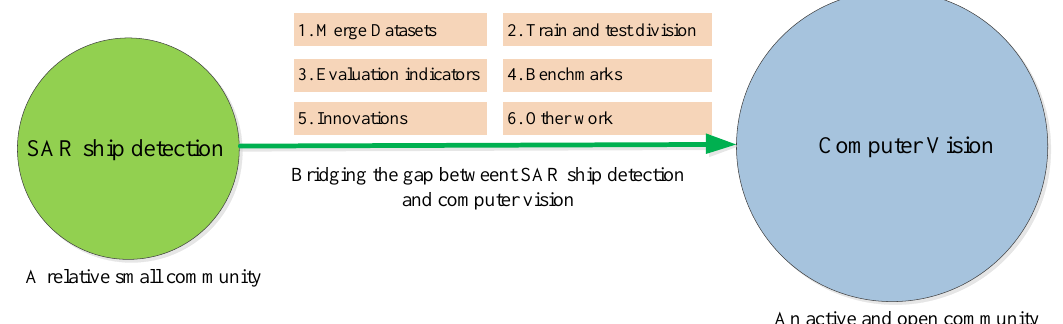
Figure 15. Bridging the gap between SAR ship detection and computer vision.